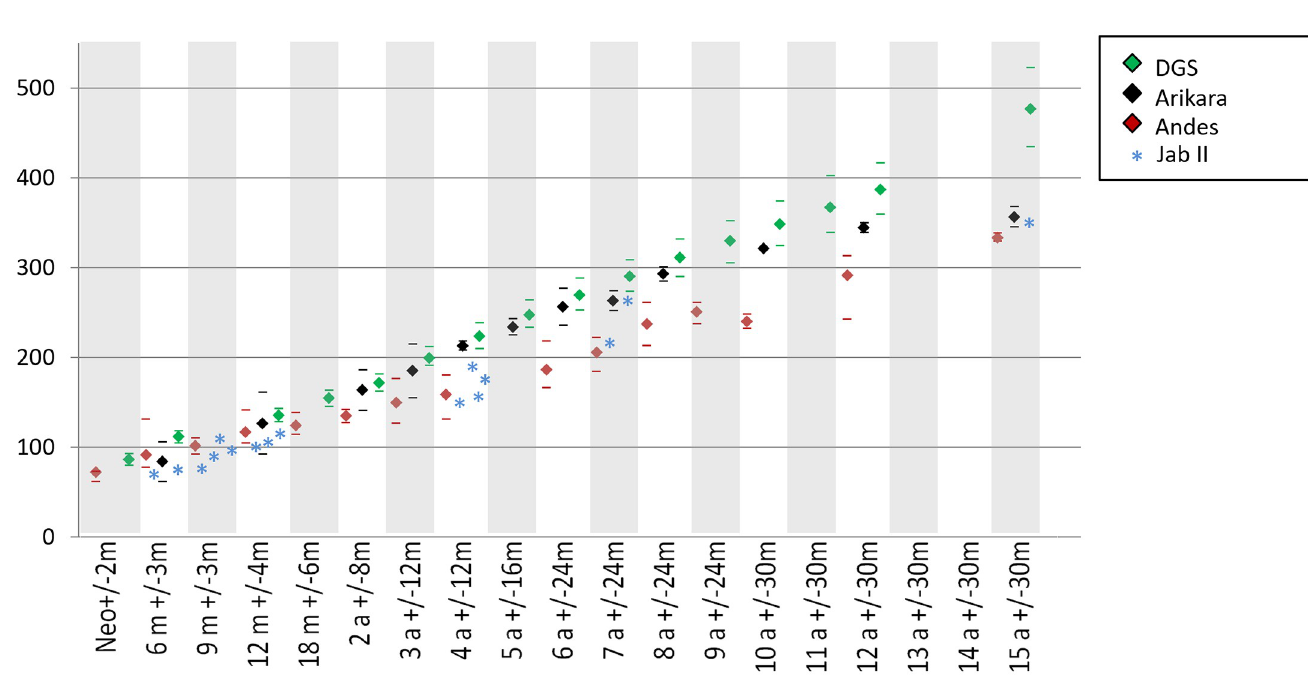
Fig 2. Femoral lengths by age in juveniles from Jabuticabeira II and reference populations. Asterisks represent the individual values of Jabuticabeira II juveniles. For the compared populations marks represent mean values and the lines represent the range of variability. DGS: Denver Growth